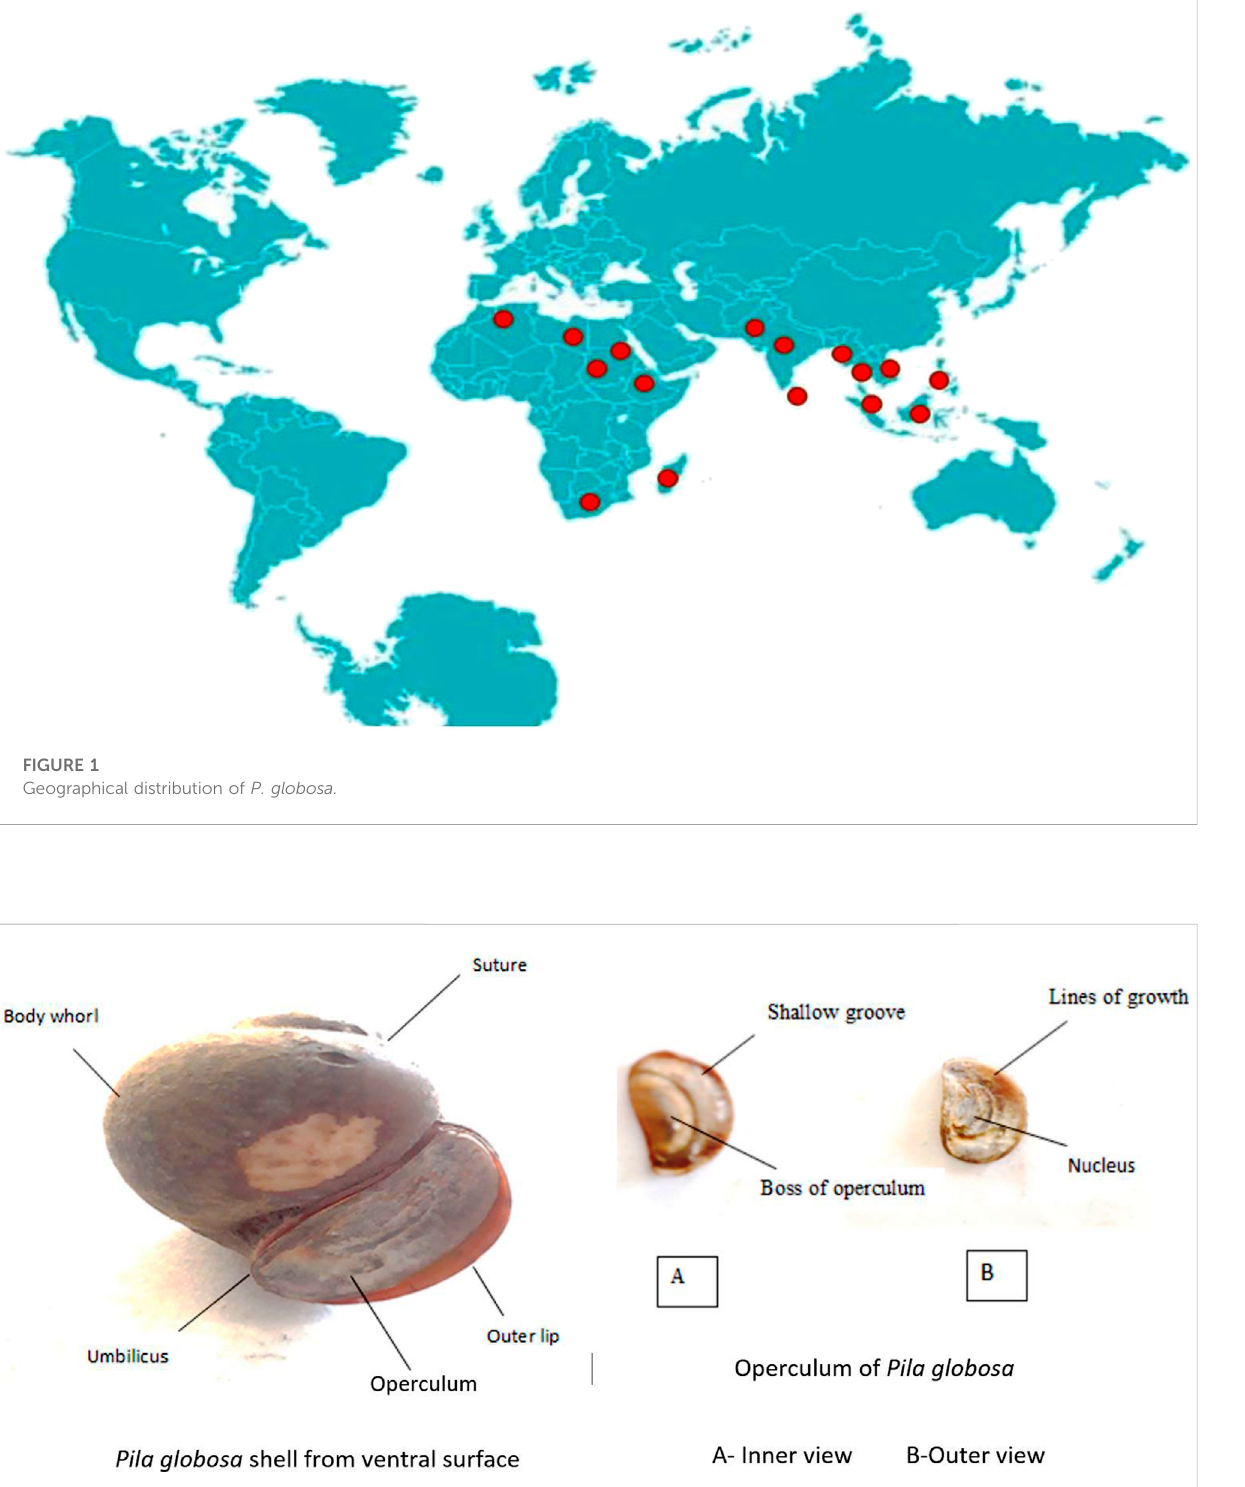
FIGURE 2 Morphology of P. globosa . The internal body parts are protected by the globular body of P. globosa, which is closed by the aperture. There are 3 – 7 circular lines of growth present on the outer surface of the operculum, and the innermost central circular line is called as the nucleus. Similarly, the central part of the inner surface of the operculum is called as